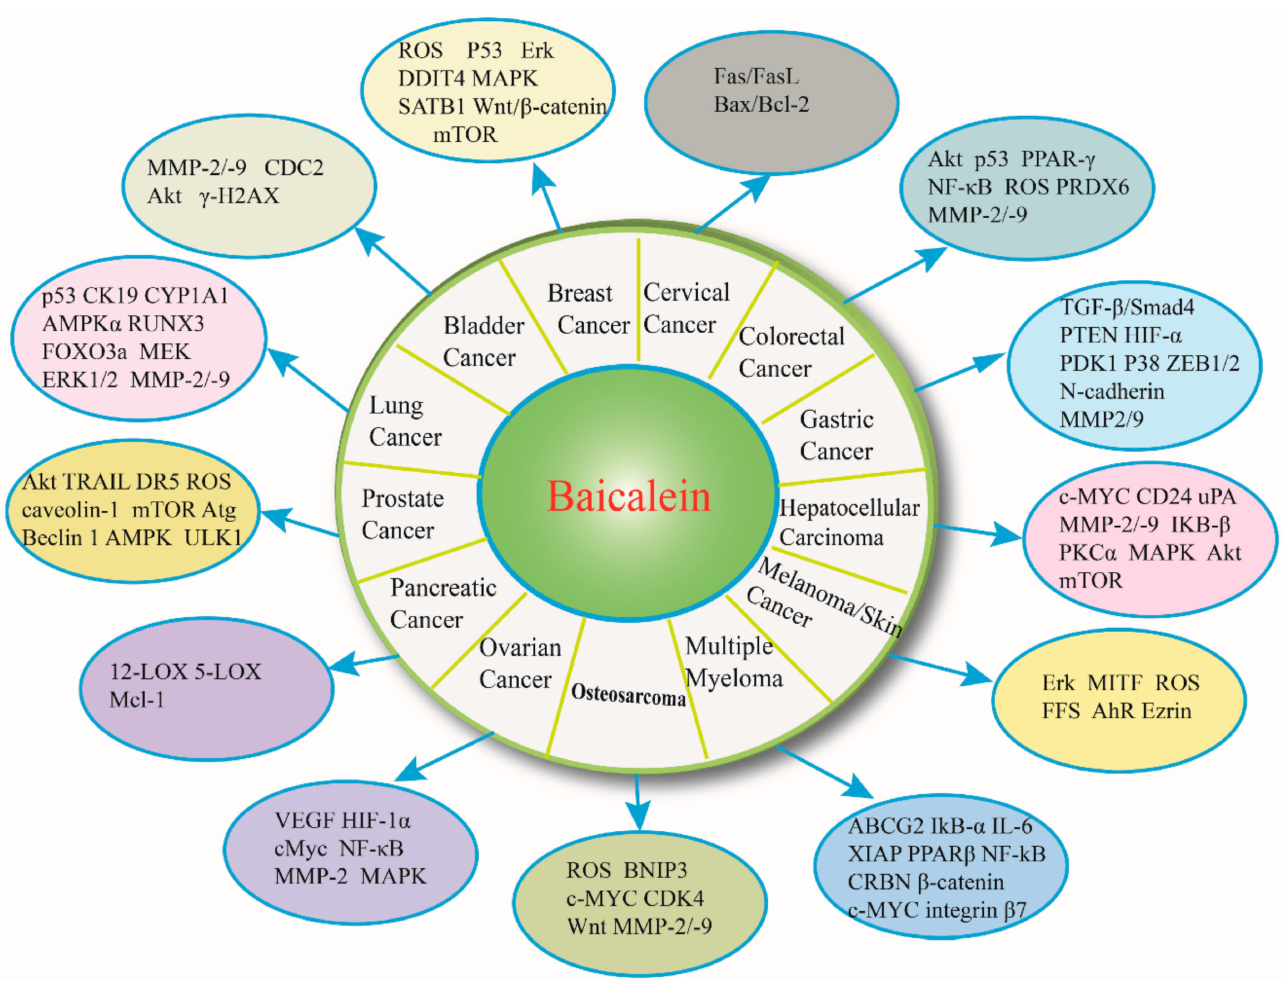
Figure 4. Baicalein anticancer activity by binding to and interacting with specific cellular targets. Reprinted from an open-access source